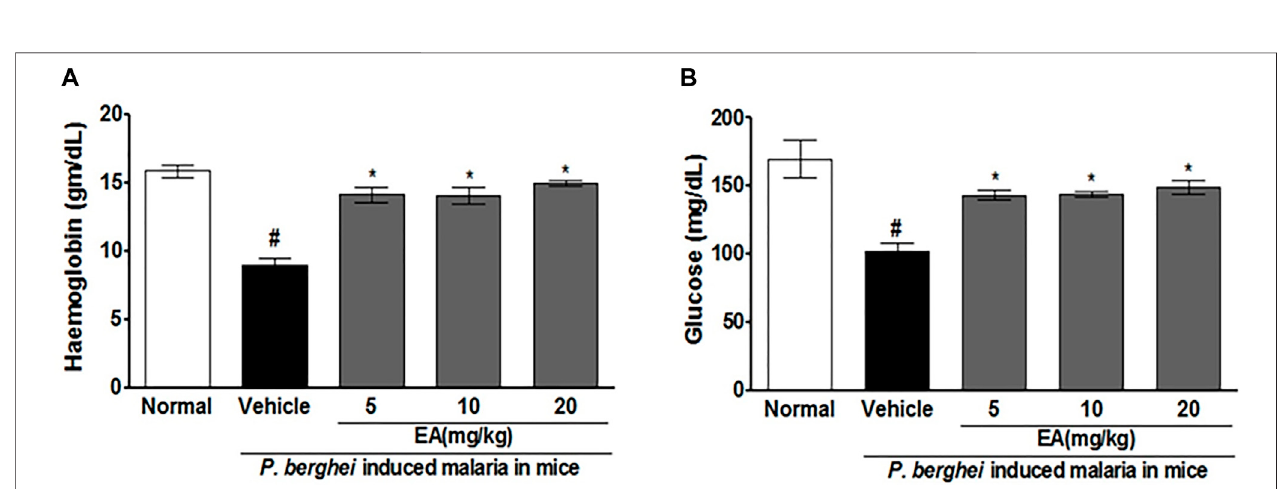
FIGURE3 | Effect of EA on haemoglobinand blood glucose level on peak day ofparasitaemia inmice. (A) Haemoglobin (B) Blood glucose. Data areexpressed as Mean ± SEM: *P < 0.05; #Normal vs vehicle treated; *Vehicle vs Treatment; n (cid:1) 3.